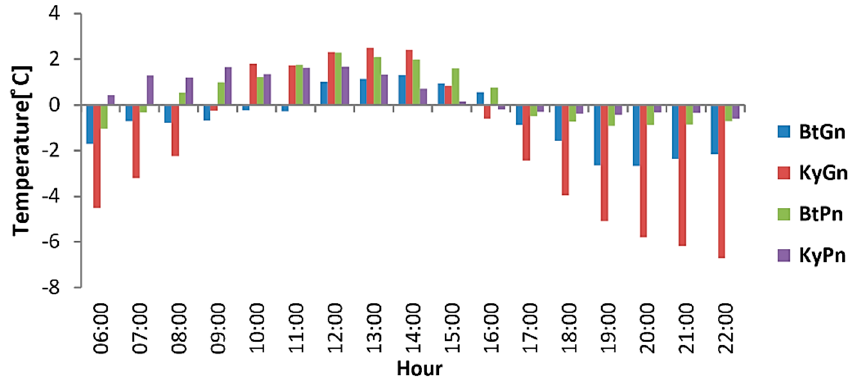
Figure 9. The difference of air temperatures in the transitional season from the wet to dry season.